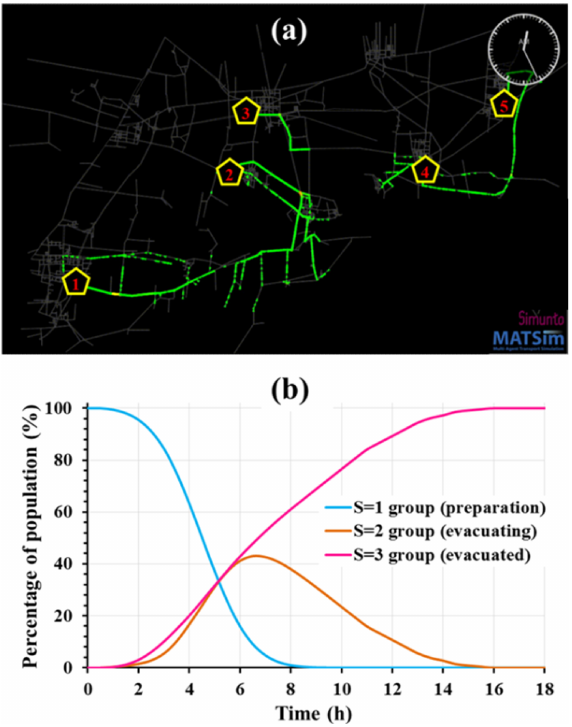
Figure 7. (a) A snapshot of residents’ evacuation schemes when all five evacuation shelters are established in the study area. (b) The percentages of the population in the three groups of agents. Note that the S = 1 group includes agents who have not started evacuat- ing, S = 2 includes agents who have started evacuating but have not arrived at an evacuation destination, and S = 3 includes agents who have successfully arrived at their destinations.